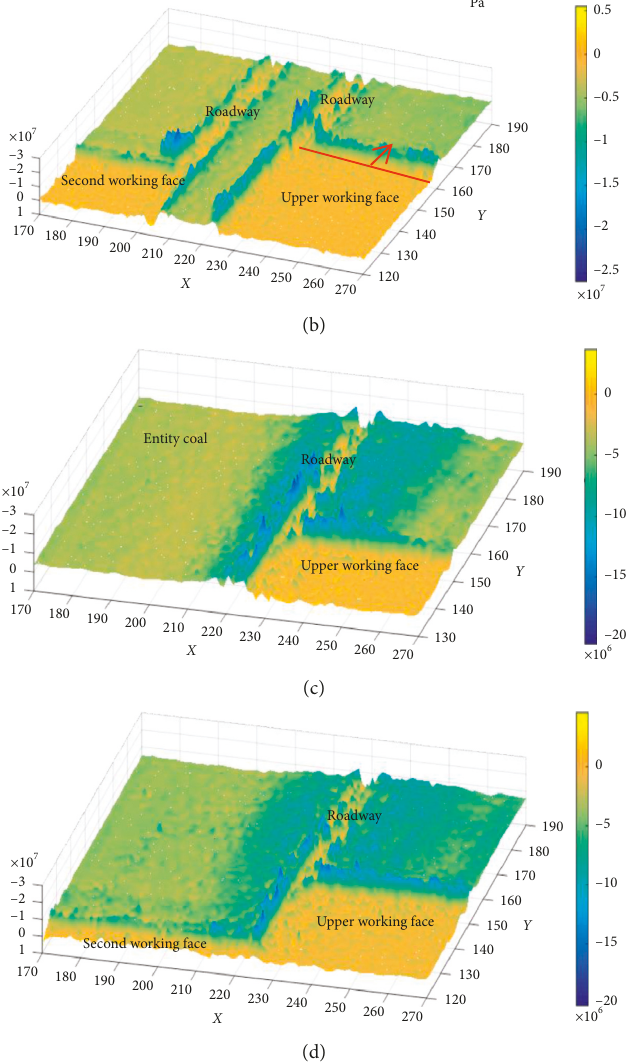
Figure 6: Distribution of vertical abutment pressure under the conventional mining and GERPOHR condition. (a) Conventional mining to excavate upper working face. (b) Conventional mining to excavate second working face. (c) Precut overhanging hard roof mining to excavate upper working face. (d) Precut overhanging hard roof mining to excavate second working